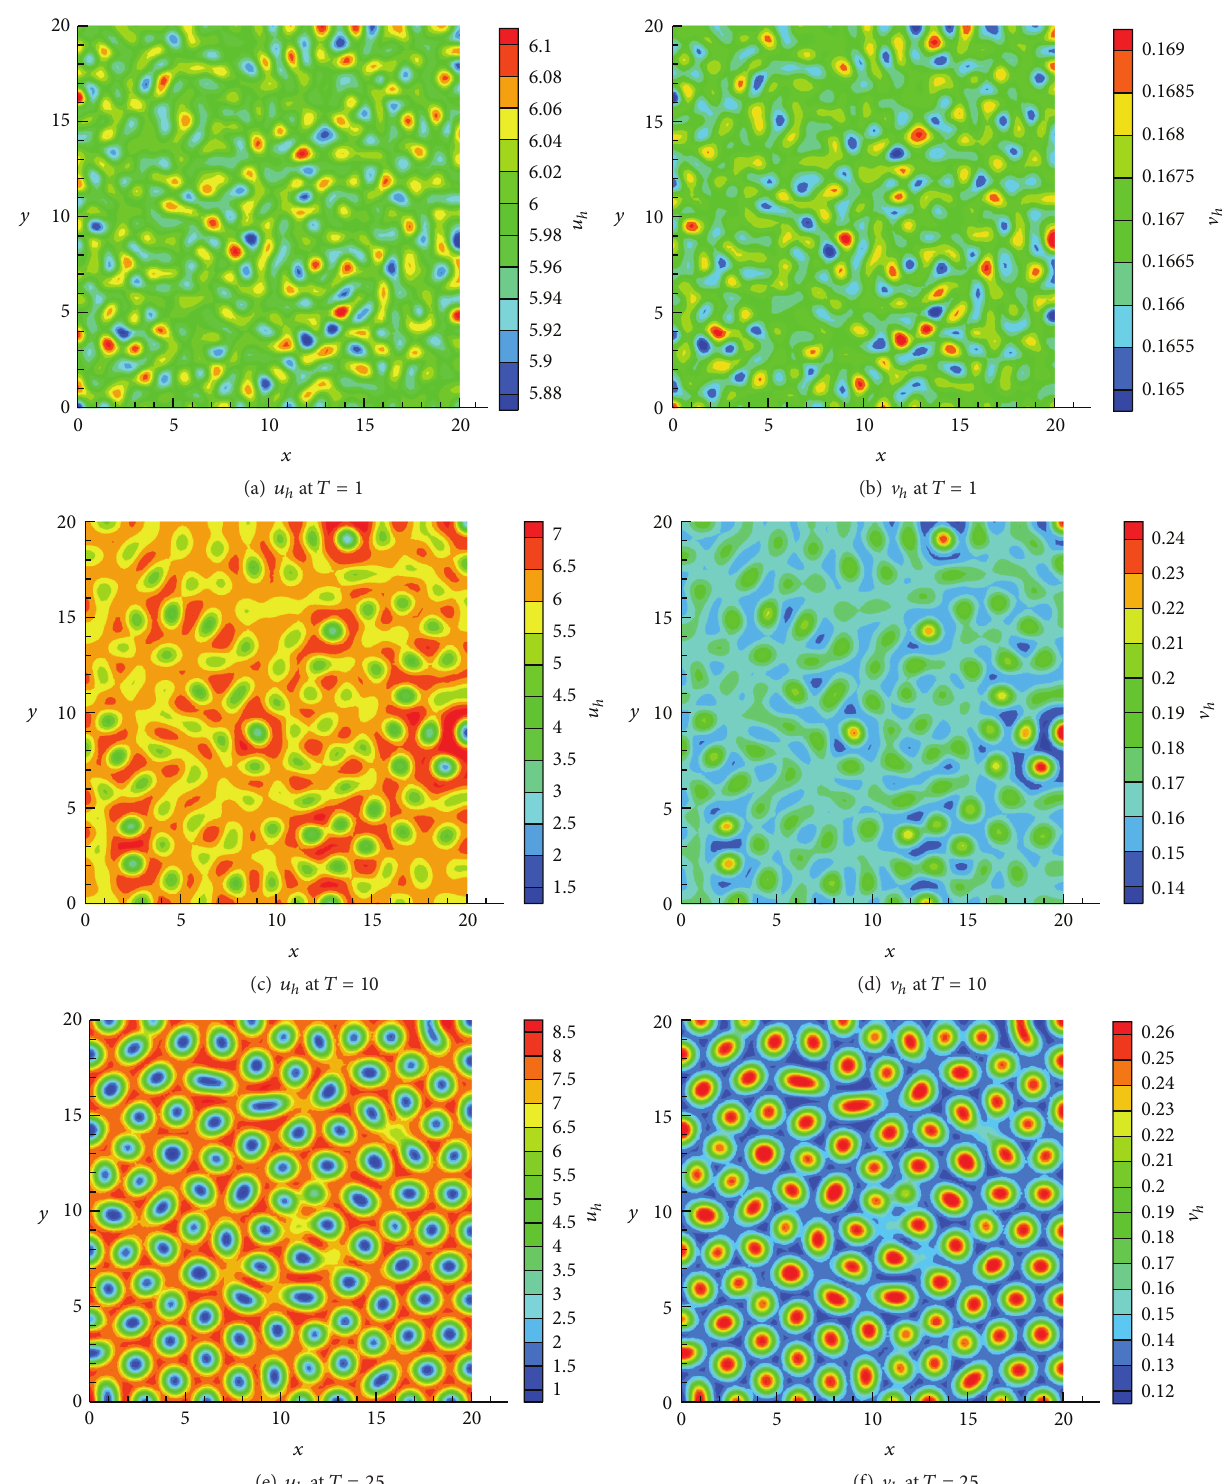
Figure 5: The time evolution of numerical solutions 𝑢 ℎ (left) and V ℎ (right) on the square domain with 𝑏 12 = 24